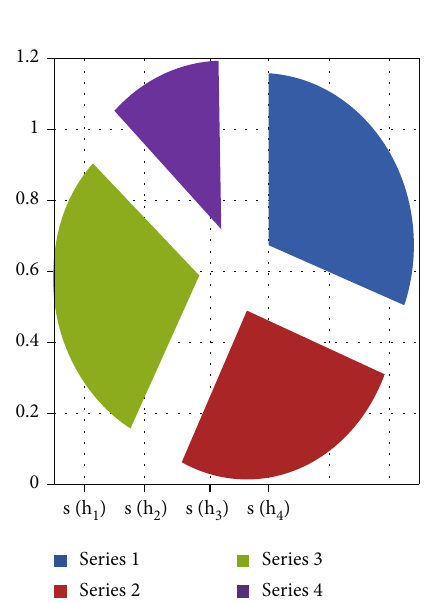
Figure 3: Graphical approach of proposed operator.